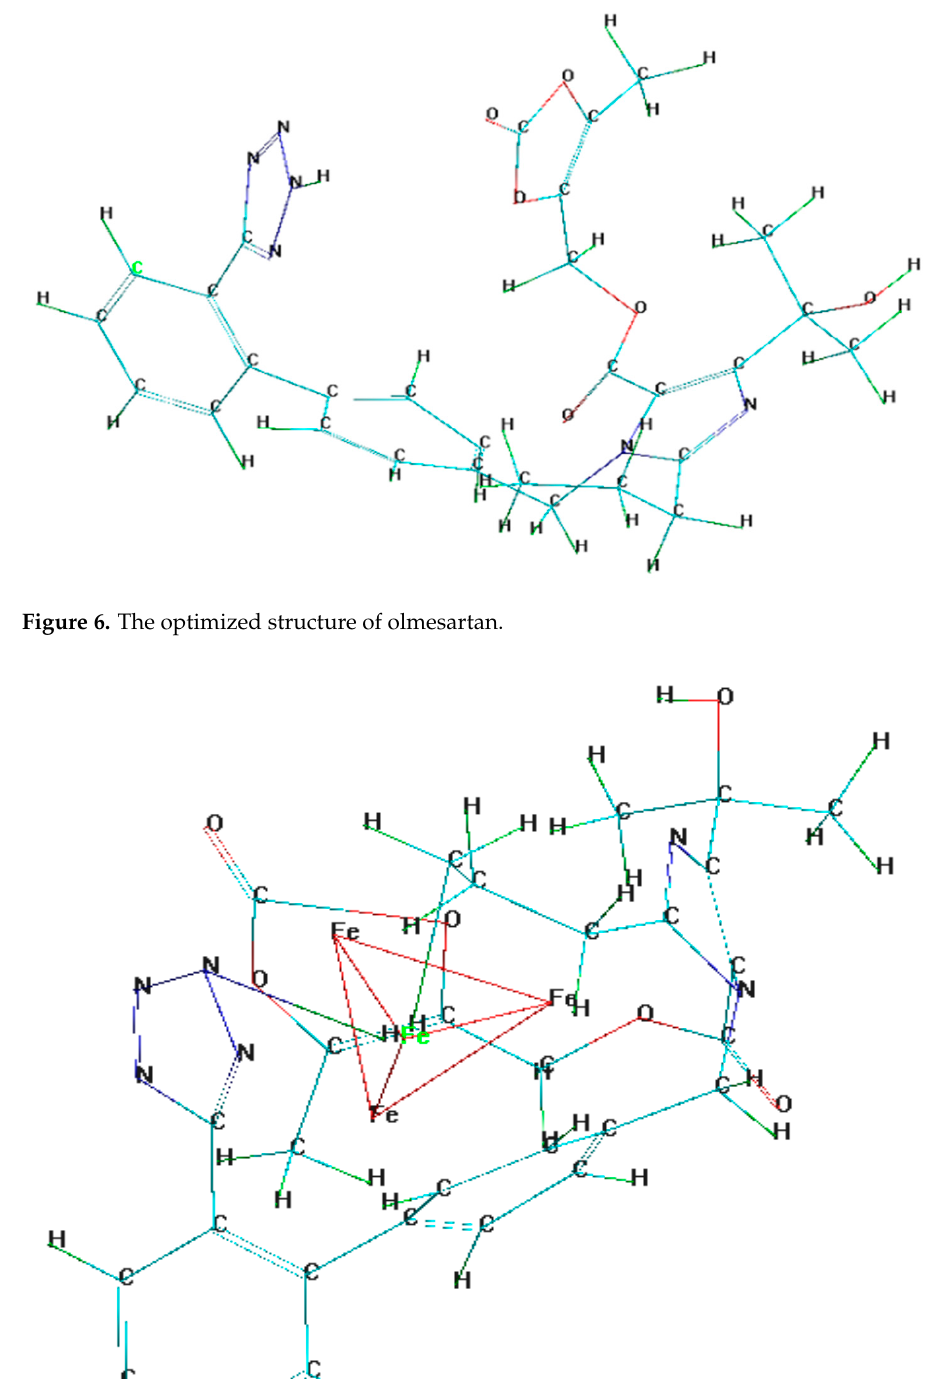
Figure 5. Interaction of Fe (110) with olmesartan molecule.